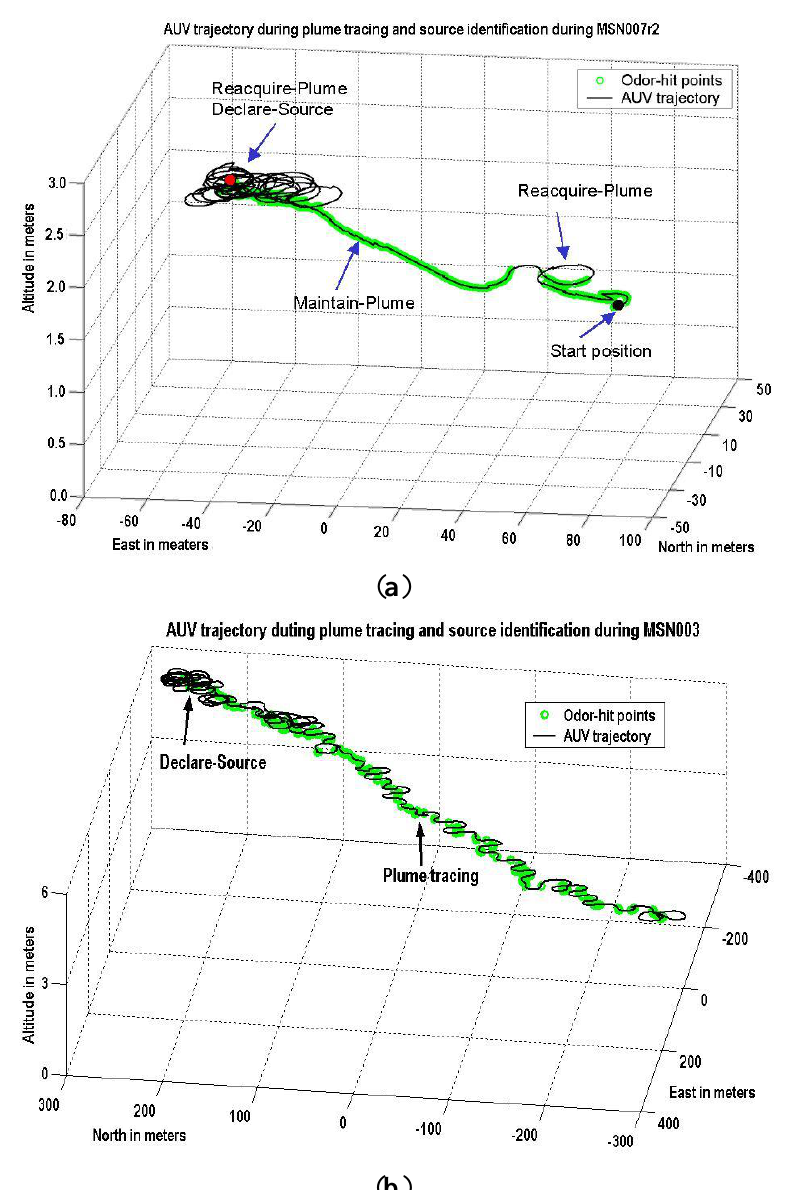
Figure 1. Identify the chemical source using the SIZ_T algorithm. ( a ) The first successful CPT in a near-shore ocean environment was conducted in November 2002 on San Clemente Island (California, USA). The mission MSN007r2 documented over distance of 411 meters from the first detection point to the identified source location. ( b ) The MSN003 mission at Duck (North Carolina, USA) in June 2003 tracked a chemical plume with the longest distance over 975 meters between the first point of chemical detection and the identified source